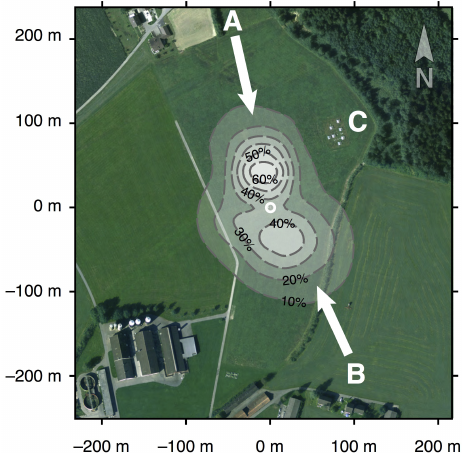
Figure 5. Example of a footprint calculation for the CH-Cha grass- land site, Switzerland. Footprint calculations from Zeeman et al. (2010) placed on orthoimage © 2014 swisstopo (JD100042). The footprint shows the typical two-lobe pattern associated with diurnal up-valley winds (a) and nocturnal down-valley winds (b) . Experi- mental treatments (c) are placed close to the eddy covariance sys- tem (round circle) but outside the main footprint area to minimize